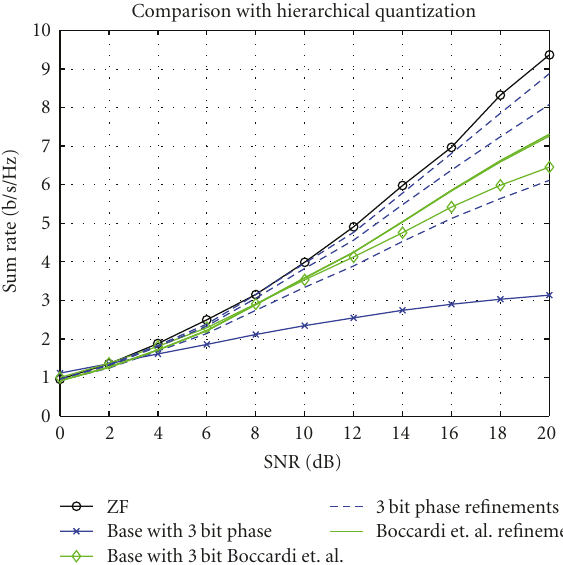
Figure 4: Sum rate performance comparison of multiuser MIMO with N t = U = 2 in an uncorrelated Rayleigh channel. The dashed lines correspond to increasing numbers of 3 bit phase refinements while the solid lines with no markers correspond to increasing numbers of refinements for the Boccardi et. al. algorithm (which happen to overlap).